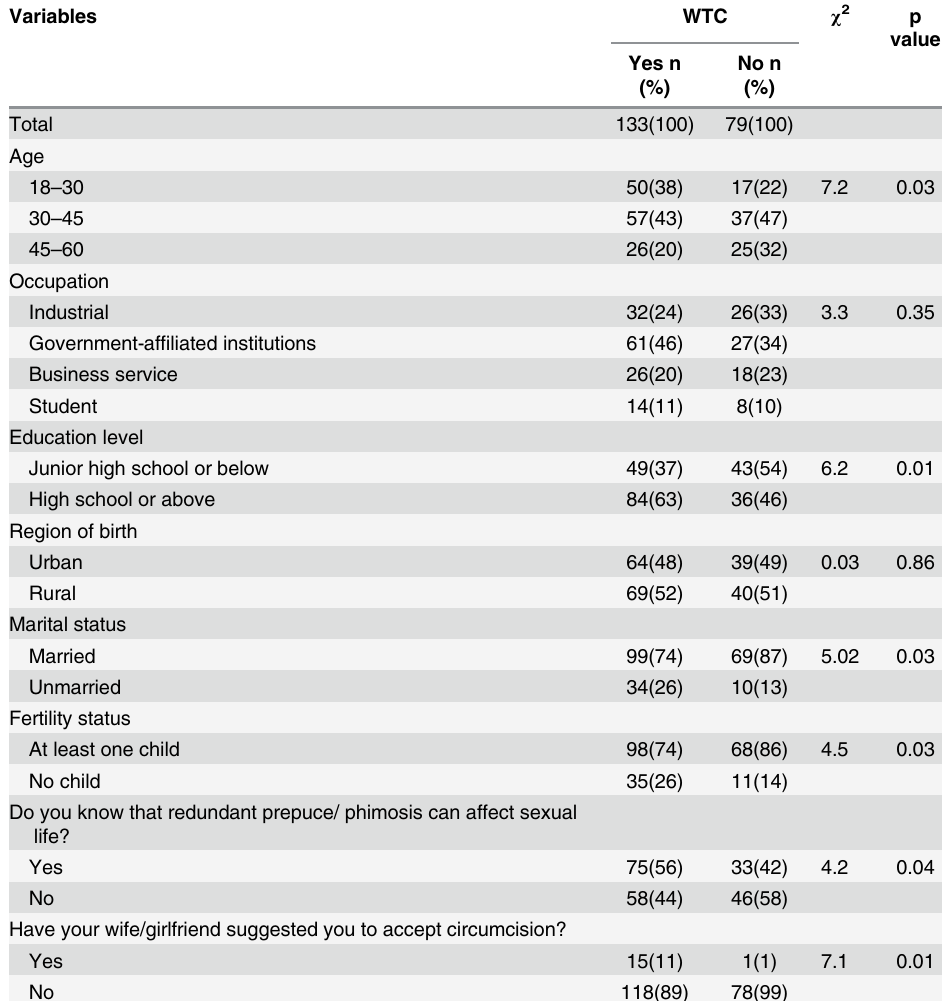
Table 5. Factors Associated with